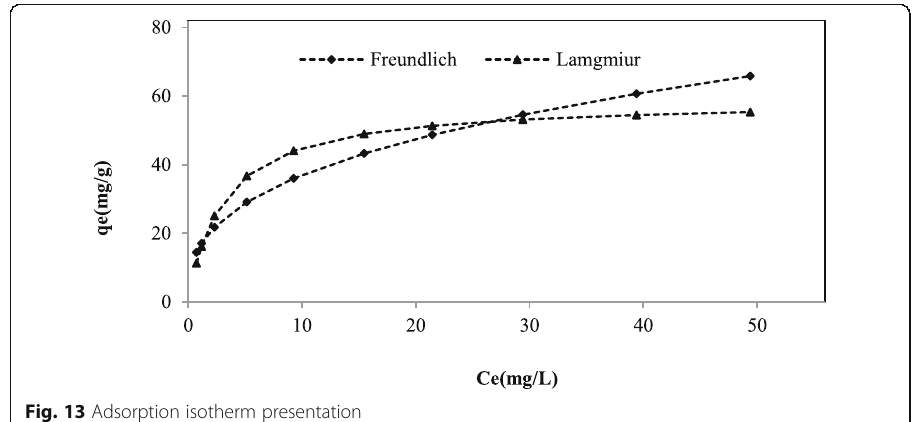
Fig. 13 Adsorption isotherm presentation